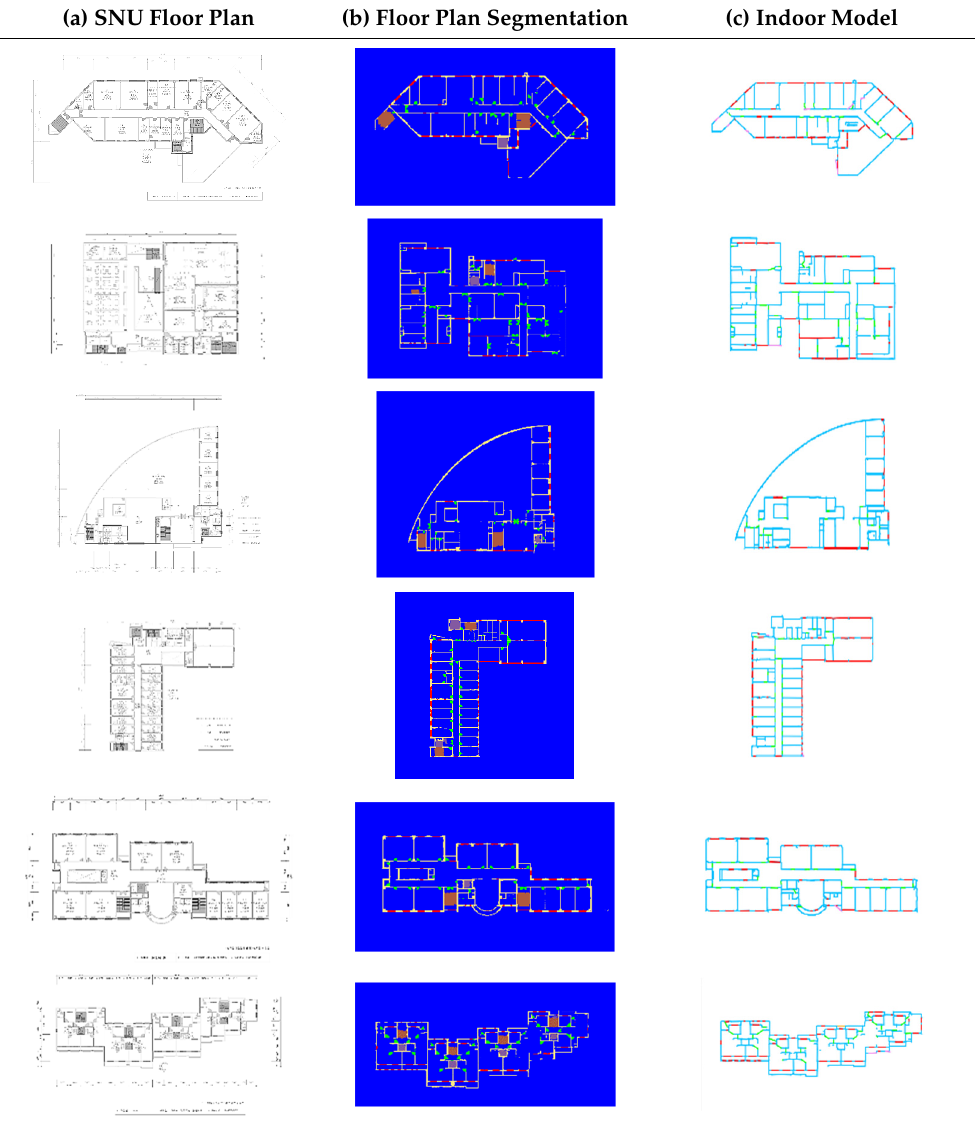
Table 2. Deep learning result.